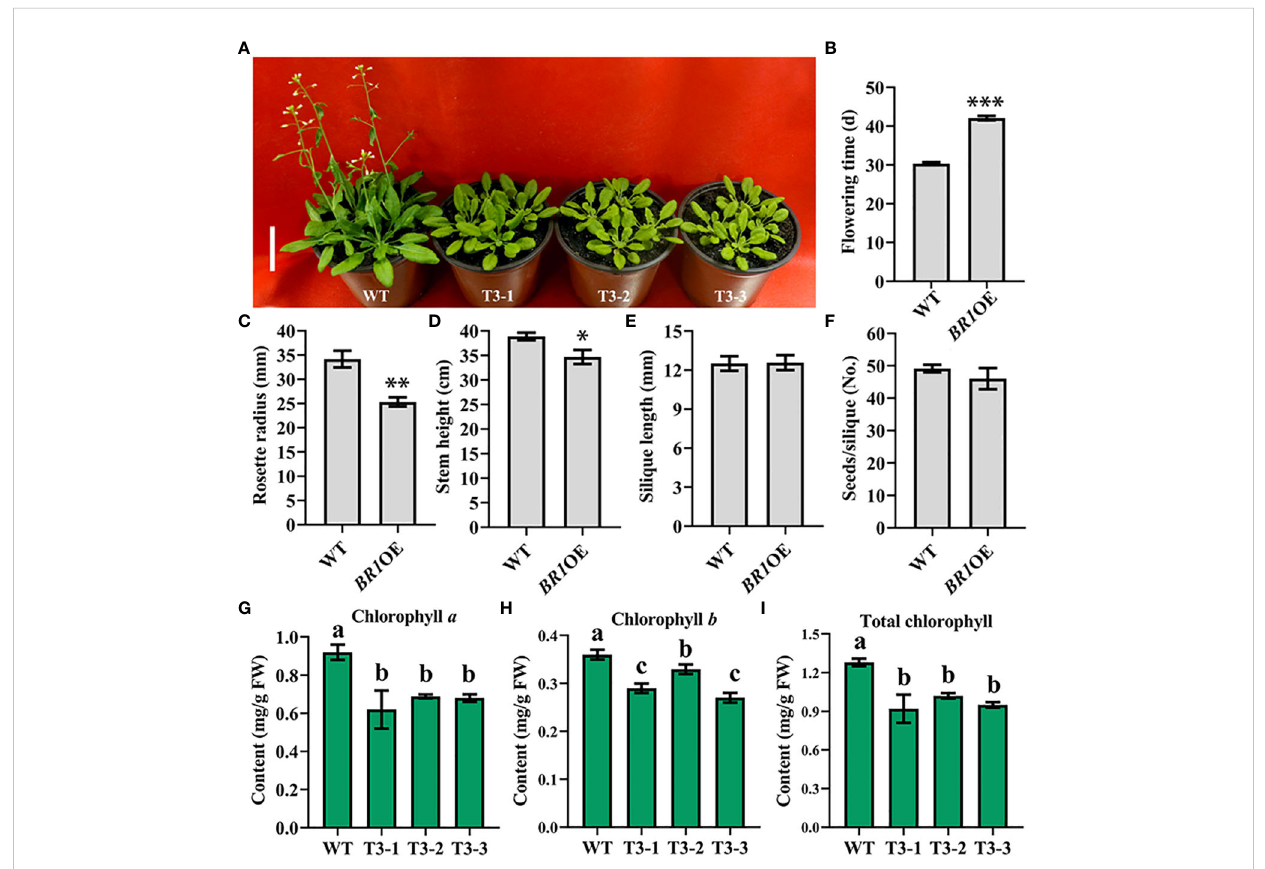
FIGURE 4 BR1 OE mutant phenotypic characterization. (A) Under LD conditions the BR1 OE transgenic plant exhibited a late- fl owering phenotype. Representative images of 32-day-old transgenic plants from three separate genetic transformation events (T3-1, T3-2, and T3-3) and wild-type Col- 0 (WT) are shown. Scale bar: 4 cm. (B) Flowering time. (C) Rosette radius. (D) Stem height. (E) Silique length. (F) Seed number per silique. Data are means ± SE of three independent measurements. Signi fi cantly differences were identi fi ed when comparing WT and BR1 OE plants using Student ’ s t -